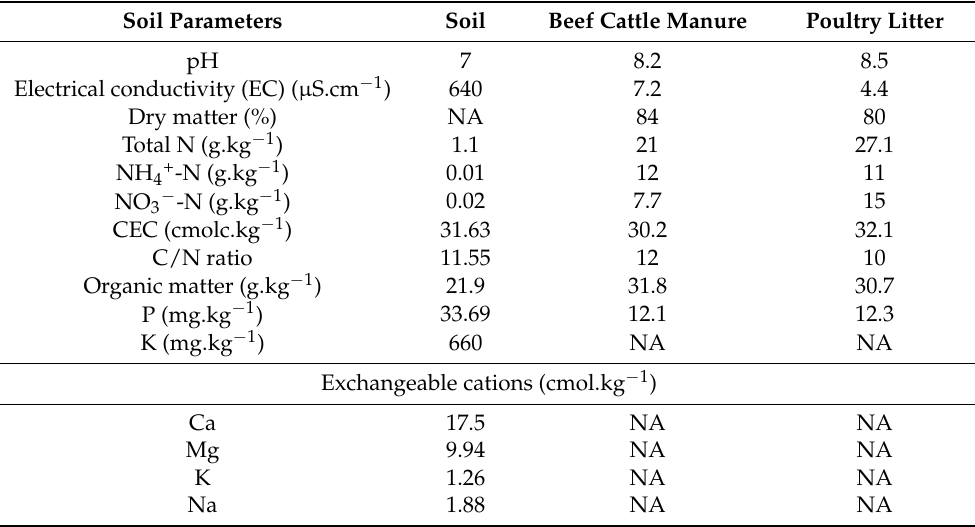
Table 2. Properties of the soil and organic fertilizer used in the experiment. Soil Parameters Soil Beef Cattle Manure Poultry Litter pH 7 8.2 8.5 Electrical conductivity (EC) ( µ S.cm − 1 )